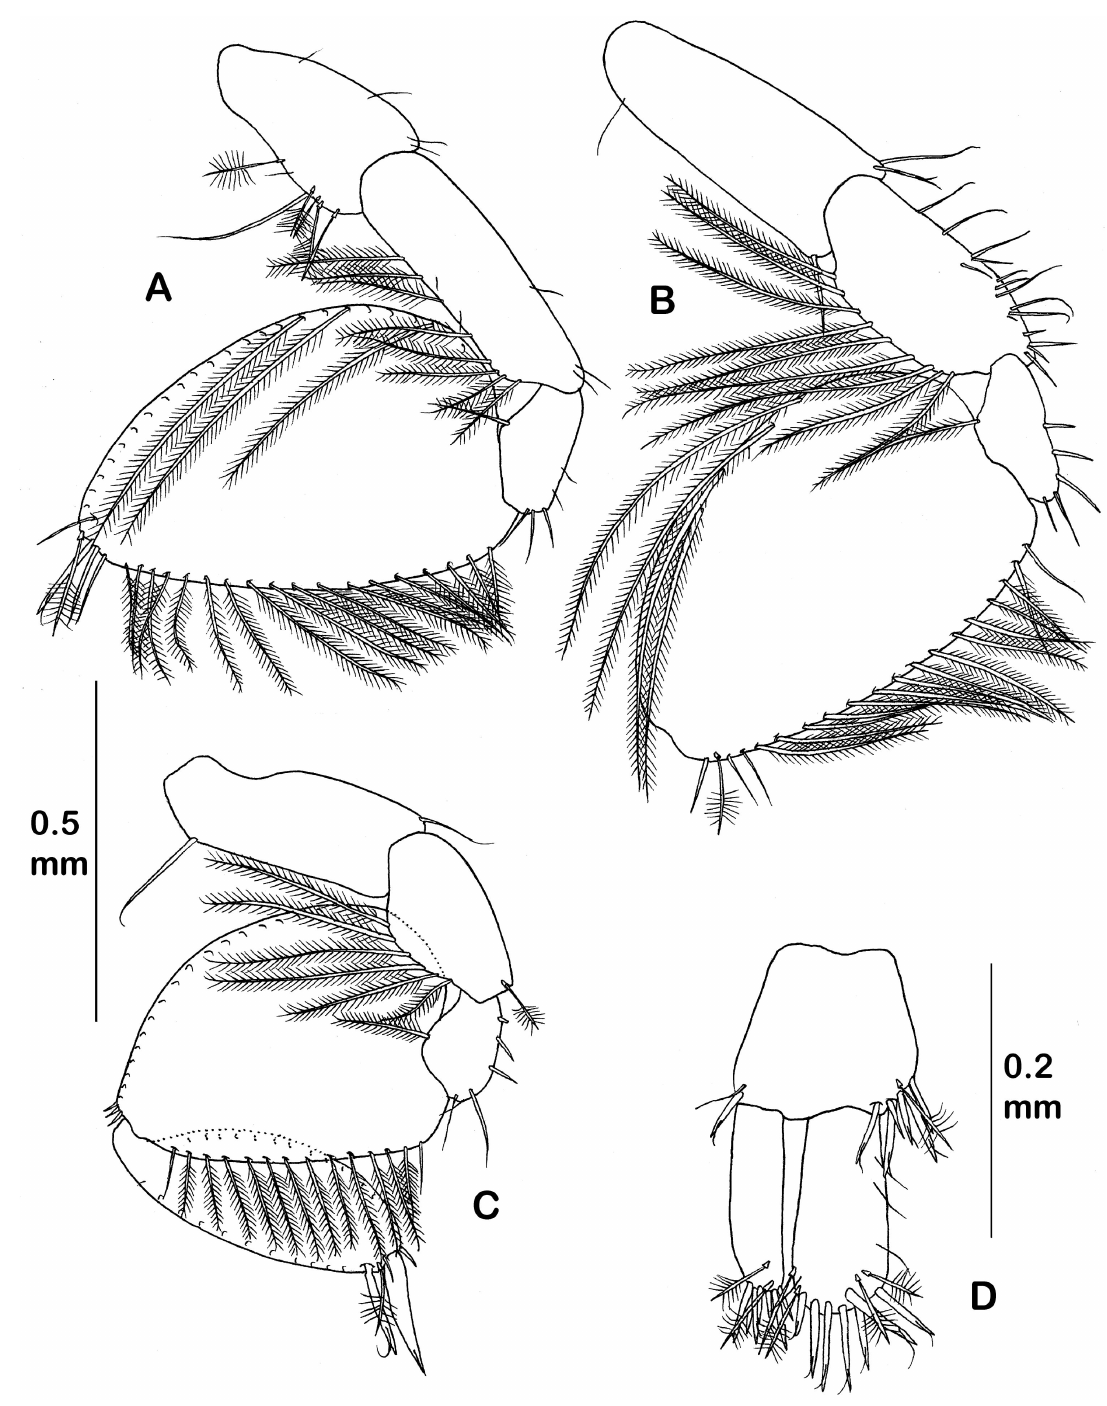
Figure 7. Eurycope producta GO Sars, 1868. Male (ZMH K-45592): ( A ) pereopod V; ( B ) pereopod VI; ( C ) pereopod VII; ( D ) uropod. Pereopod VI (male, ZMH K-45592, Figure 7B) propodus and dactylus broken